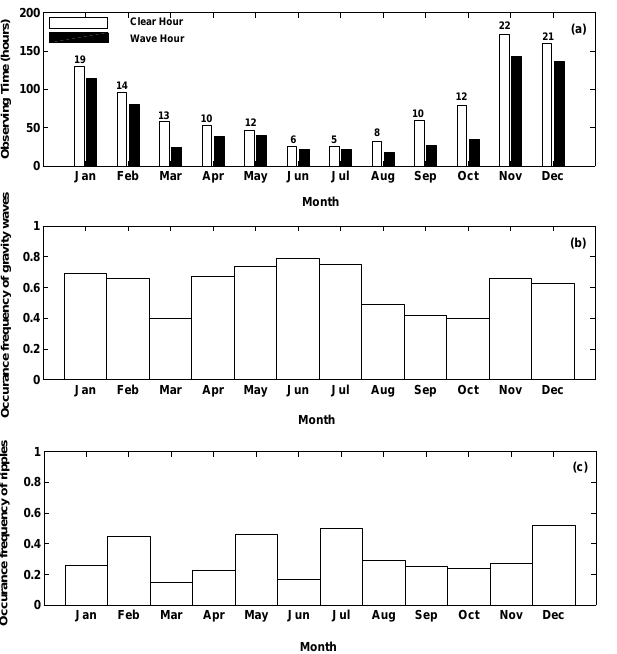
Fig. 3. (a) Monthly mean weather condition from December 2009 to November 2010 (open bar), and the monthly mean wave structure (bands and ripples) observing hours (black column). The numbers above bar show the clear sky nights per month, (b) occurrence fre- quency of gravity waves, (c) occurrence frequency of ripples.